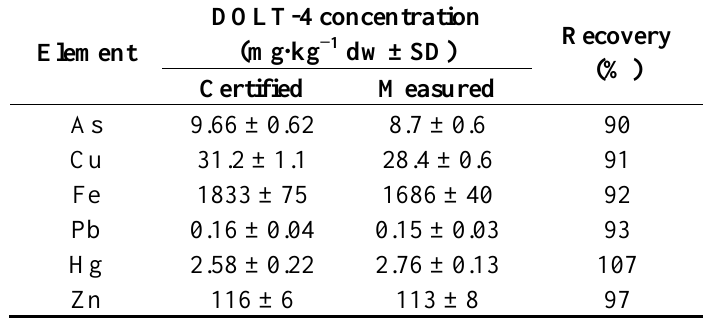
Table 1. Accuracy (given as recovery) and precision (given as standard deviation) of standard DOLT-4, analyzed by the procedure employed in fish metal(loid)s analysis. DOLT-4 concentration Recovery (mg∙kg −1 dw ± SD) Element (%) Certified Measured